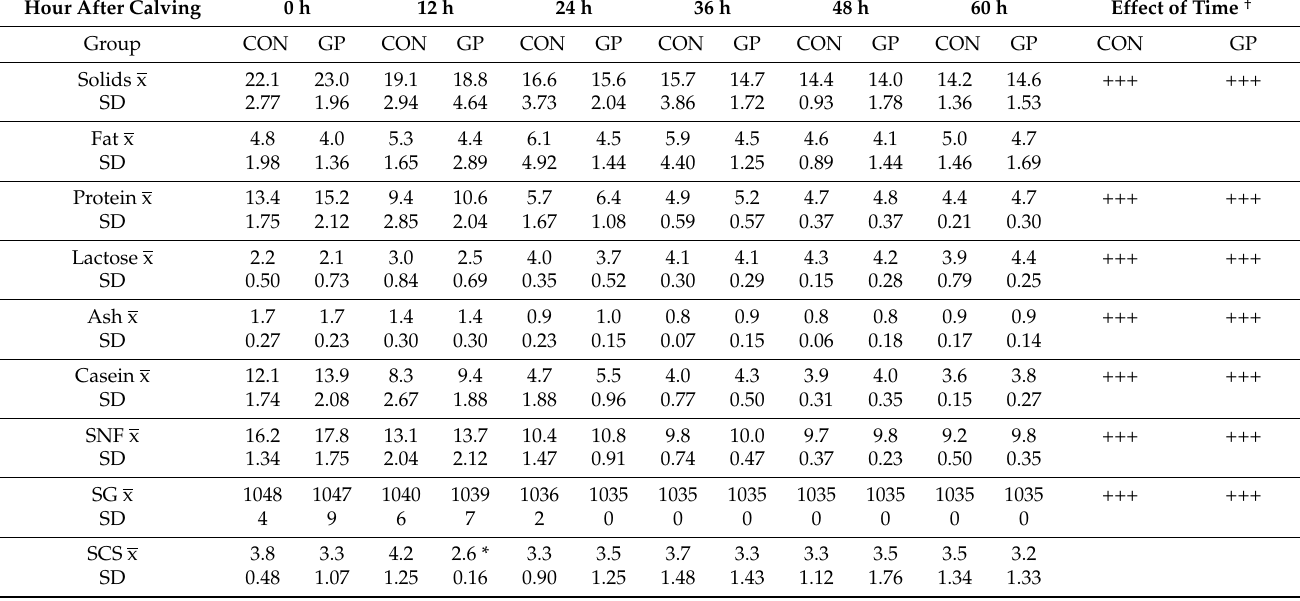
Table 2. The characteristics of cow colostrum during the experiment